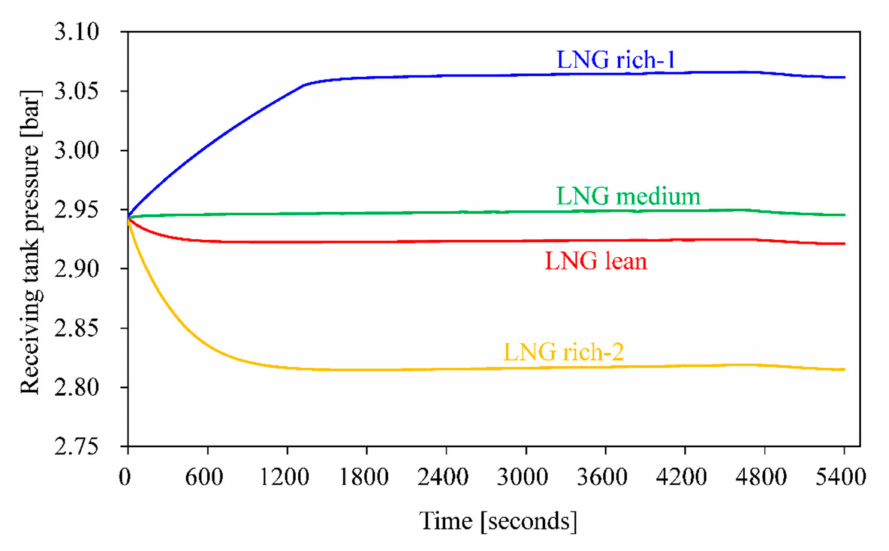
Figure 9. Variation of receiving tank pressure at di ff erent LNG